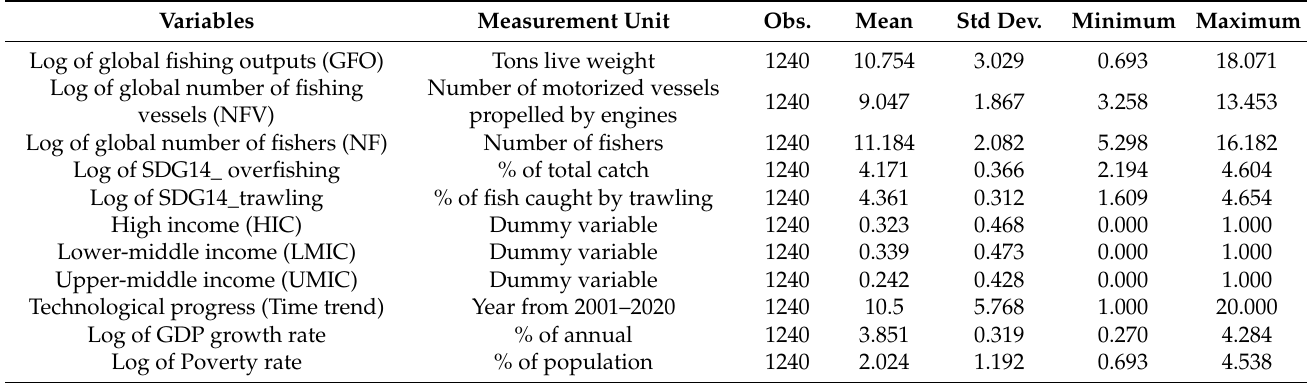
Table 2. Descriptive statistics of 62 countries,